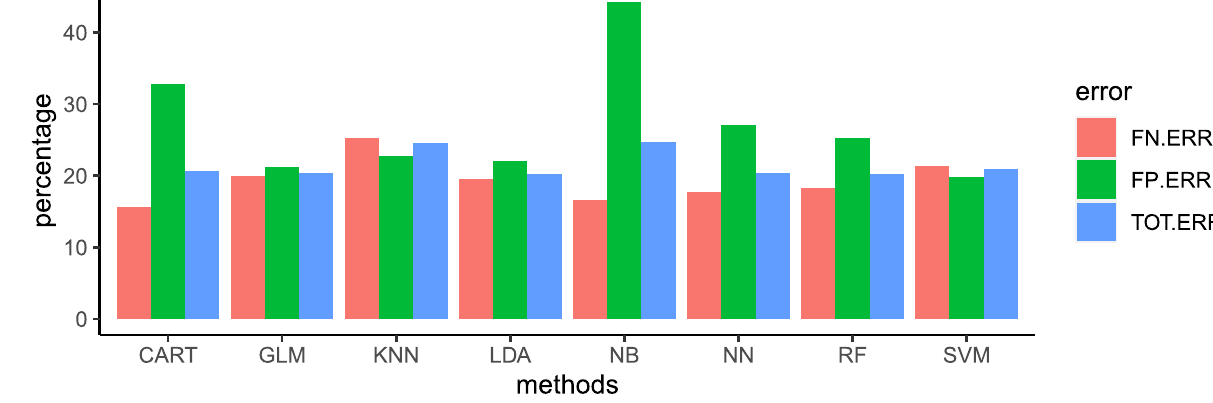
Figure 4. Comparison of the performance [false negative error (FN.ERR), false positive error (FP.ERR) and total error (TOT.ERR)] of eight machine learning methods [Classification and Regression Trees (CART), Generalized Linear Model (GLM) with logit link function, k-Nearest Neighbors (kNN), Linear Discriminant Analysis (LDA), Naïve Bayes (NB), Neural Network (NN), Random Forest (RF) and Support Vector Machines (SVM)] run on the validation set, in prediction of udder health status of dairy cows according to somatic cell count below or above 200,000 cells/mL from cow’s and milk data recorded at the previous test-day